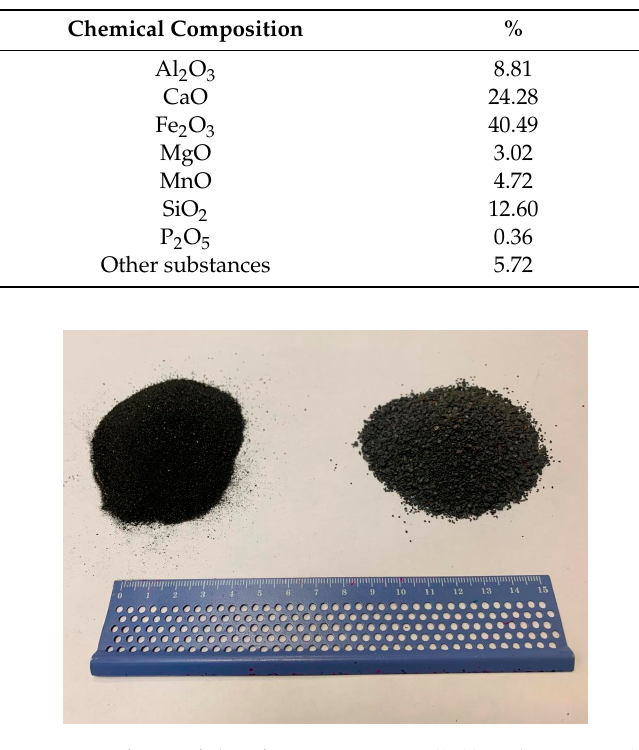
Figure 2. Mass of 50 g of slag, fraction 0.063/0.5 ( left ) and 0.5/2 mm ( right ). Table 2. Chemical composition of EAF slag.